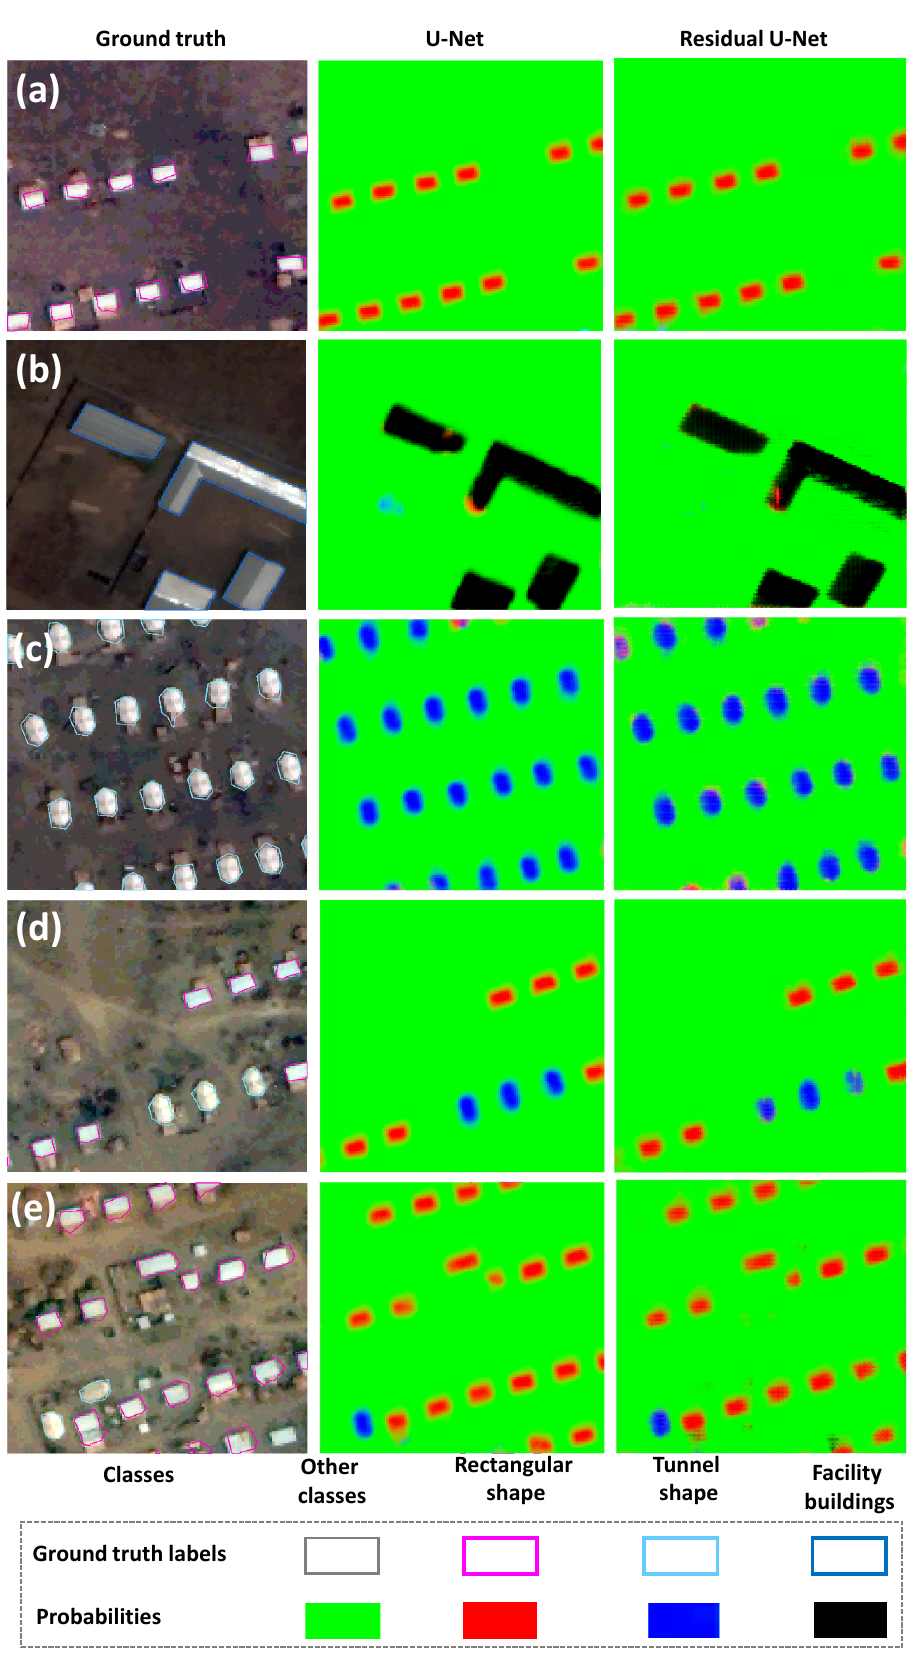
Figure 4. Heat maps demonstrate the probability distribution over different classes. The image patches ( a – e ) are selected from the test